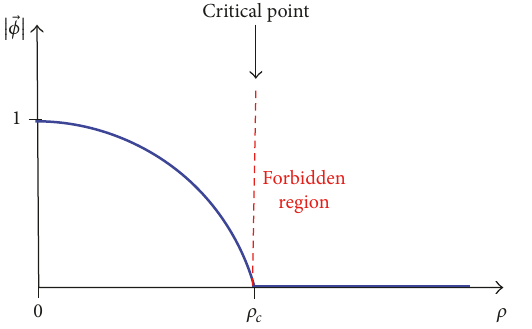
Figure 3: Modulus of the filed 𝜙 𝜇 as a function of the energy density 𝜌 . The region 𝜌 > 𝜌 𝑐 is forbidden within the